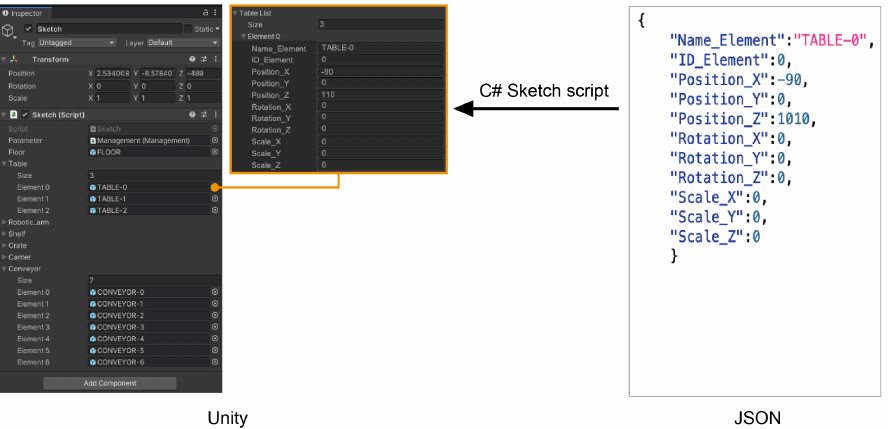
Figure 6. “Inspector” panel of the Sketch GameObject, where the feature of each element are automat- ically extracted from the JSON